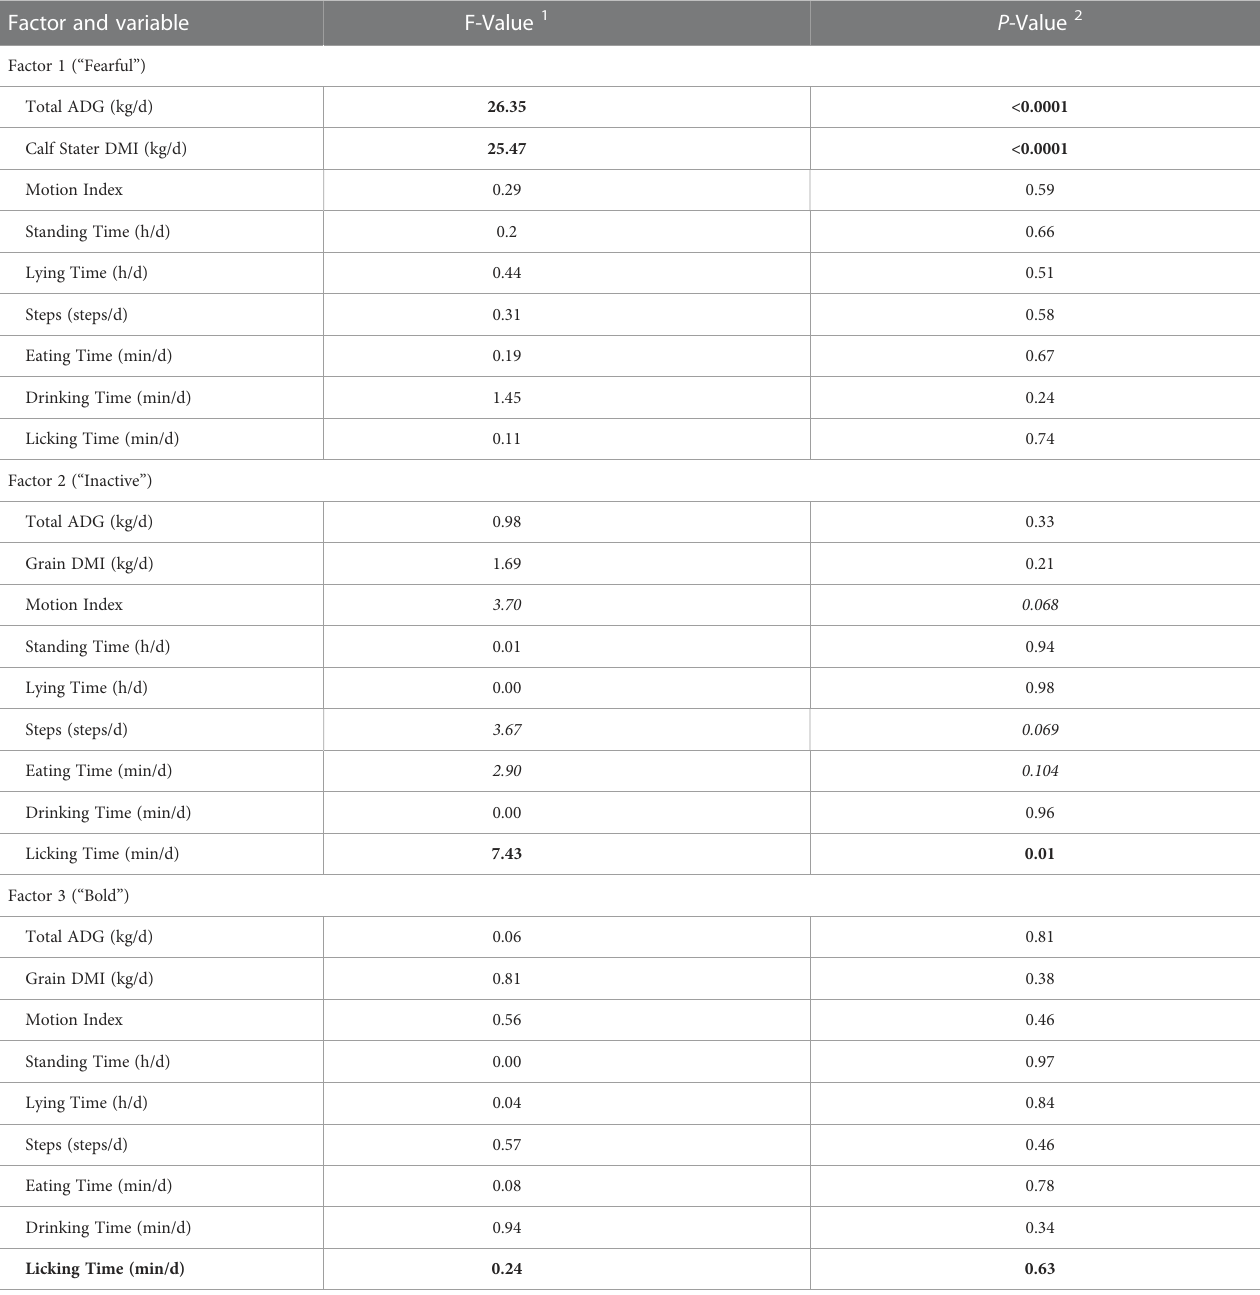
TABLE 4 Relationships between factor scores (personality traits), performance and home pen behavior of individually housed Holstein x Angus crossbred calves (n = 29) during the 76-d experimental period. Factor and